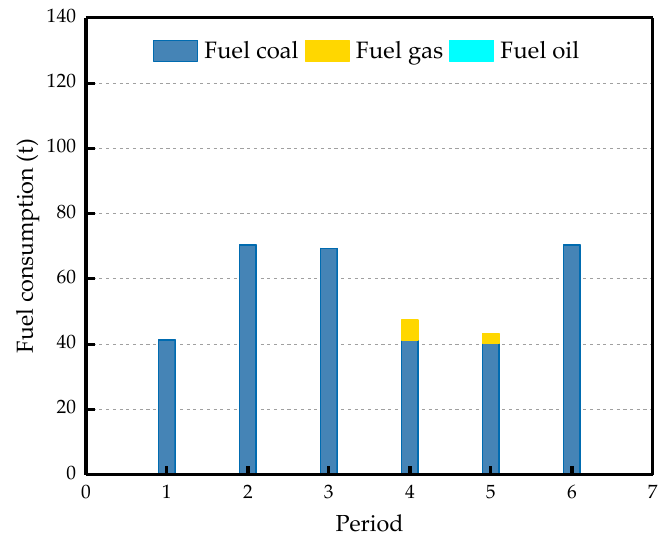
Figure 5. Optimal scheduling results for fuel.